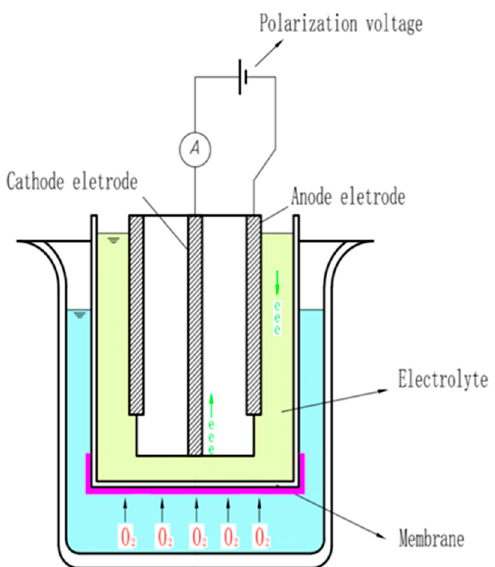
Figure 2. Structure diagram of the polarographic dissolved oxygen sensor probe.